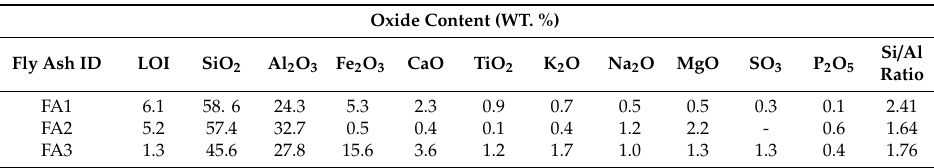
Table 1. Chemical composition of the fly ash products.